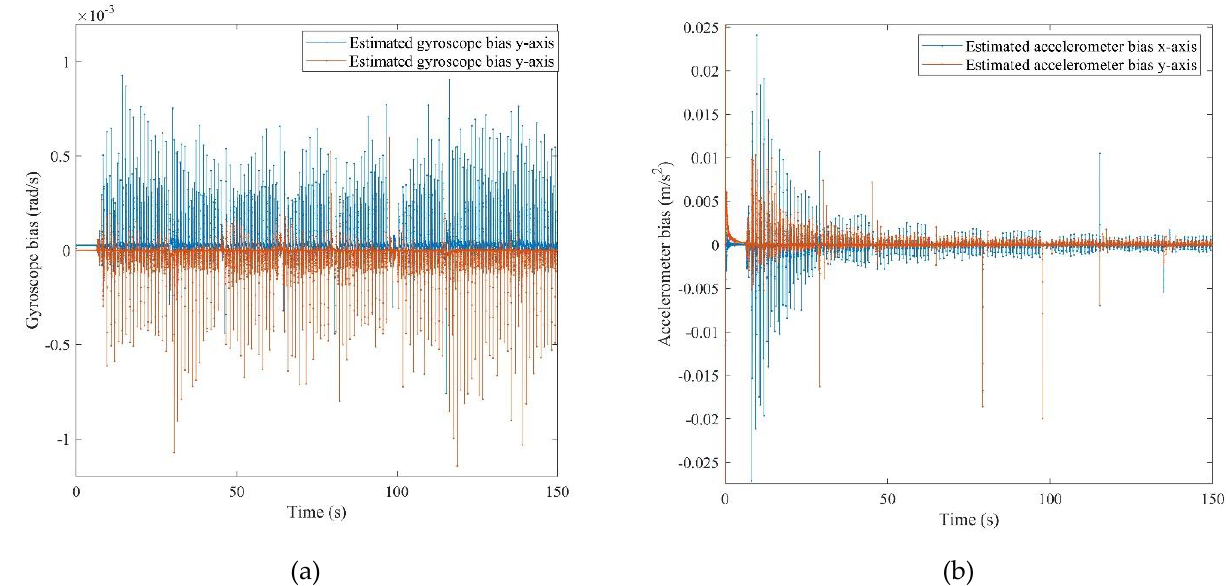
Figure 12. ( a ): Estimated gyroscope bias, ( b ): estimated accelerometer bias for x -axis and y -axis.